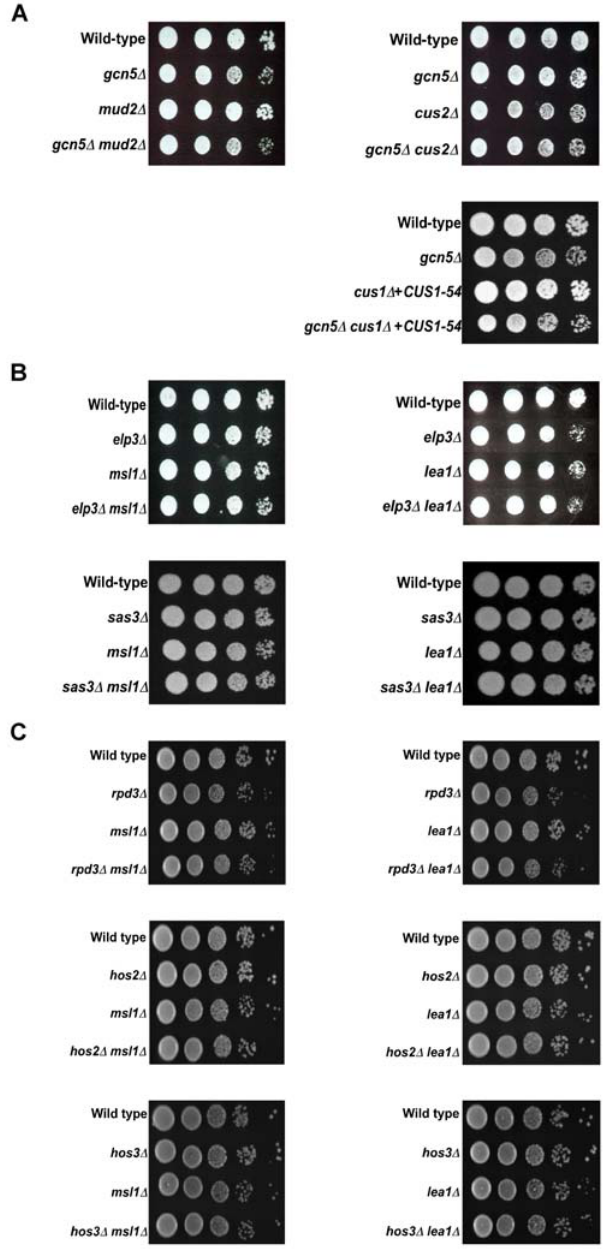
Figure 2. GCN5 genetic interactions with MSL1 and LEA1 are specific. (A) Dilution series of double mutants gcn5 D mud2 D , gcn5 D cus2 D and gcn5 D cus1 D + CUS1 2 54 . Cells were grown at 30 u C in YPD liquid medium until the desired O.D. 600 was obtained. Cells were spotted onto YPD plates as a ten-fold serial dilution. Plates were incubated at 30 u C for two days. (B) Dilution series of the double mutants elp3 D msl1 D , elp3 D lea1 D , sas3 D msl1 D , sas3 D lea1 D . Cells were treated as described in (A). (C) Dilution series of the double